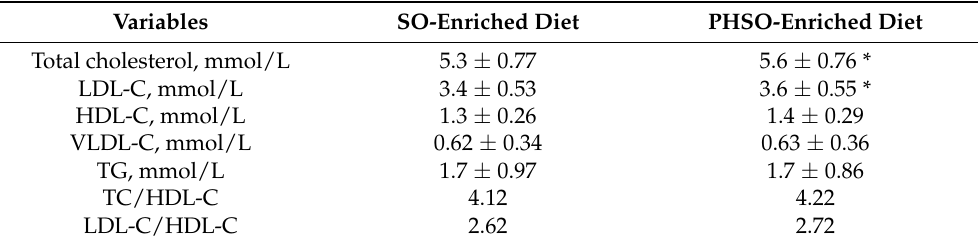
Table 1. Cardiometabolic risk factors of the study participants after consumption of the SO and PHSO-enriched